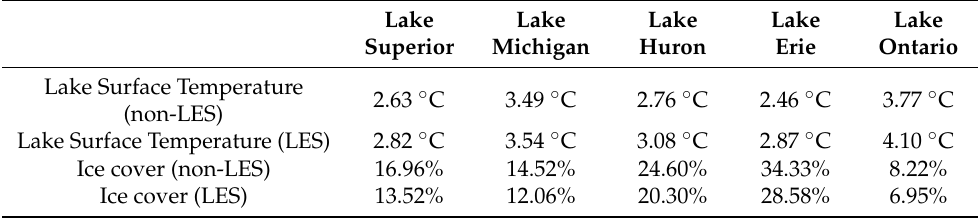
Table 4. Mean lake surface conditions during non-LES clippers for both reference longitudes and LES clippers at the start of LES formation. No differences in the means were